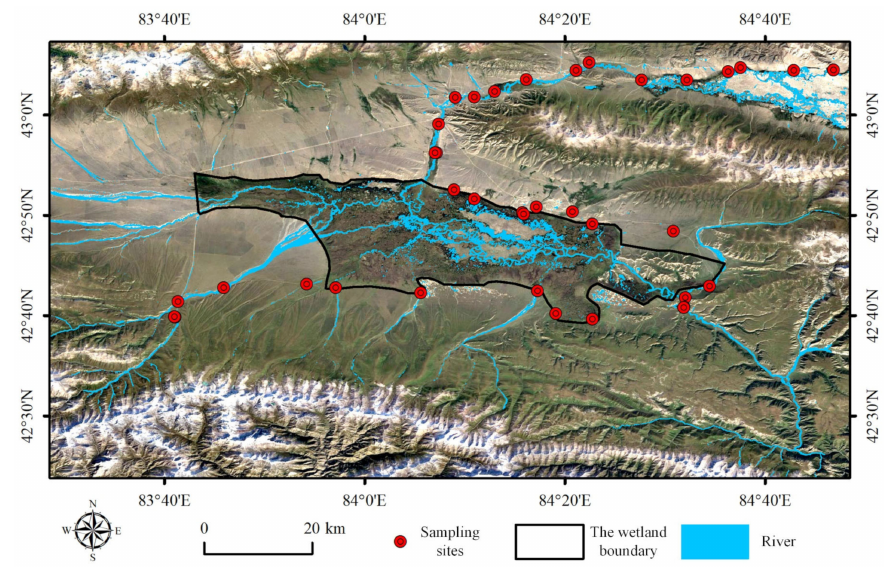
Figure 1. Sampling sites in the Bayanbulak wetland in